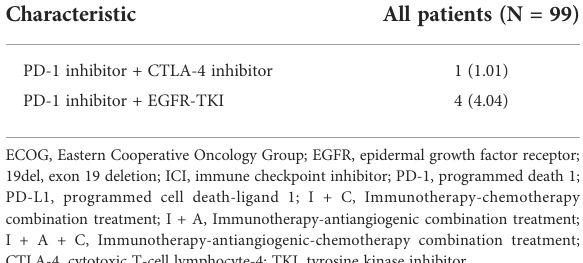
TABLE 1 Characteristics of patients with sensitive EGFR mutations receiving